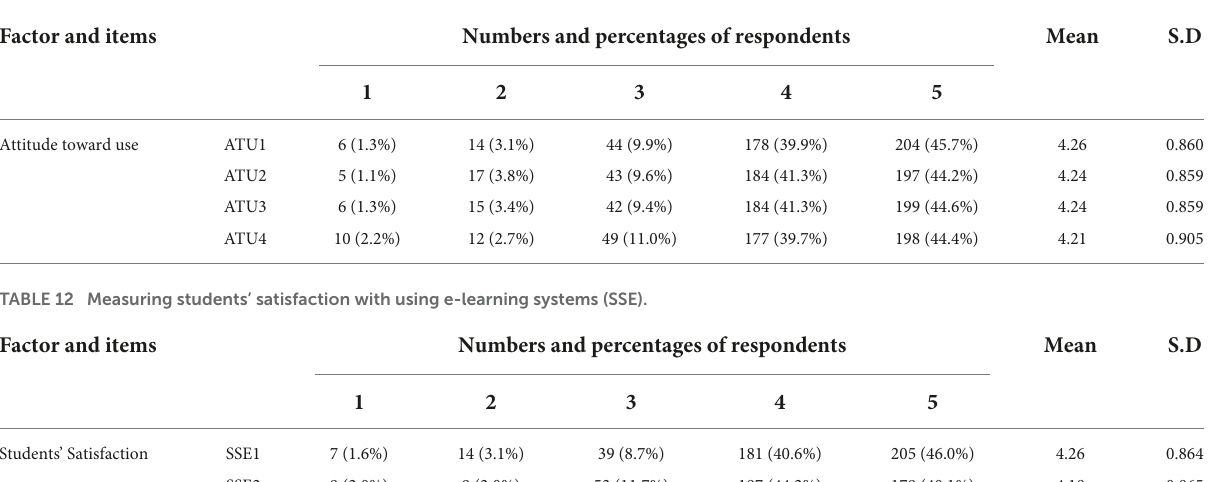
TABLE 11 Measuring attitude toward use (ATU).